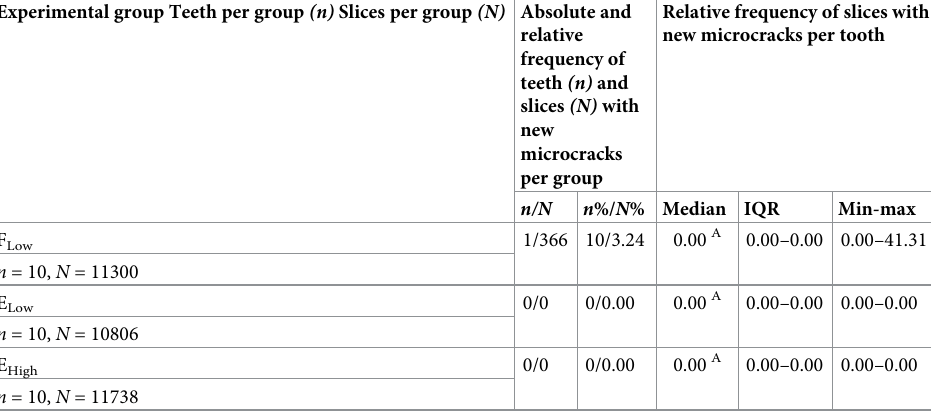
Different superscript letters indicate statistically significant differences between experimental groups